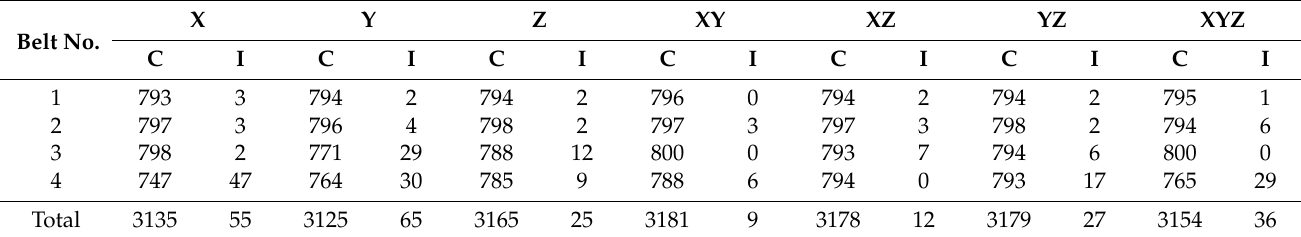
Table 16. Table 16. Accuracy summary of CNN results for three-axis dynamometer and its combination. Belt